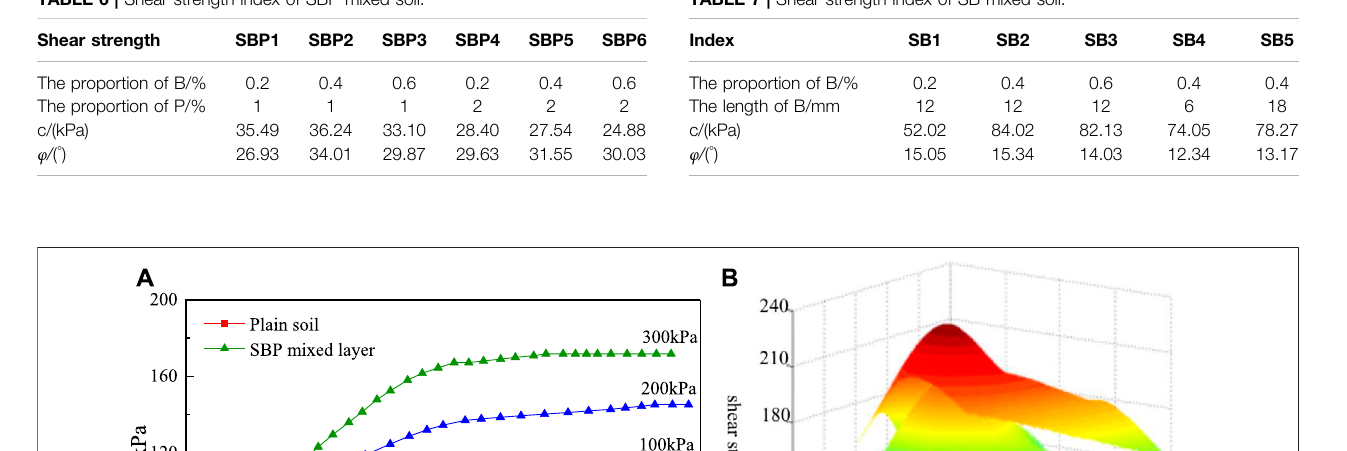
TABLE 6 | Shear strength index of SBP mixed soil.